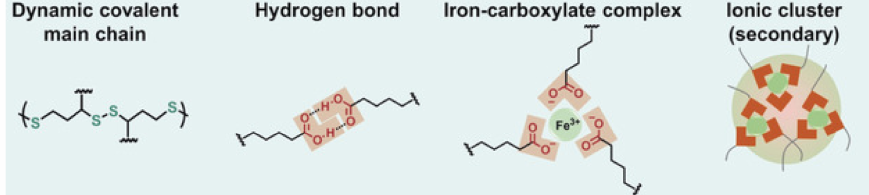
Figure 58. Diagrammatic presentation of the existing four types of dynamic combinations in the network. Reproduced from [241] with permission from John Wiley and Sons.